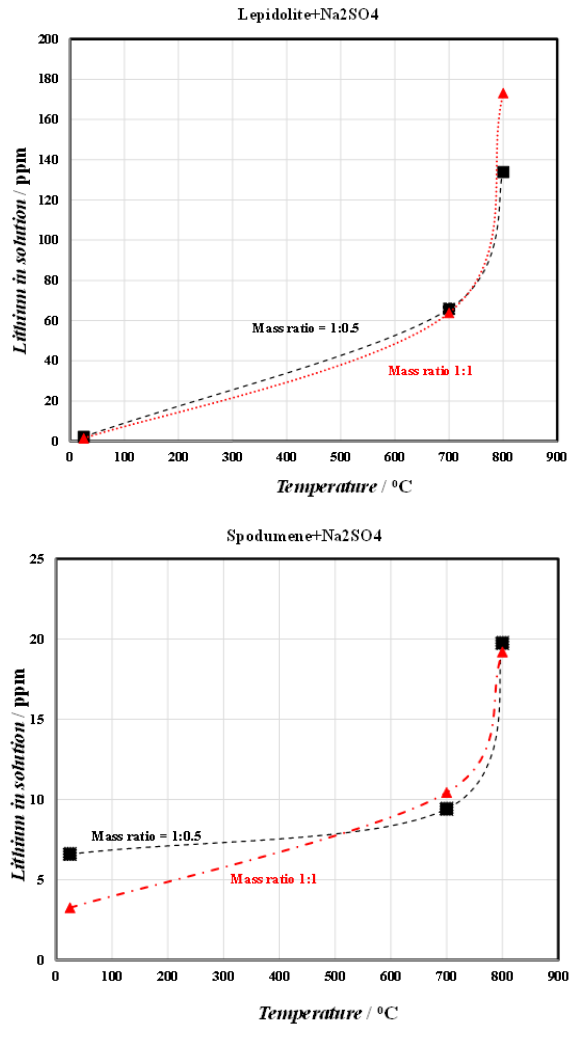
Fig. 5 . Concentration of lithium (ppm) in the liquor solutions after leaching in hot water at 80 ºC for 1 h as a function of the calcination